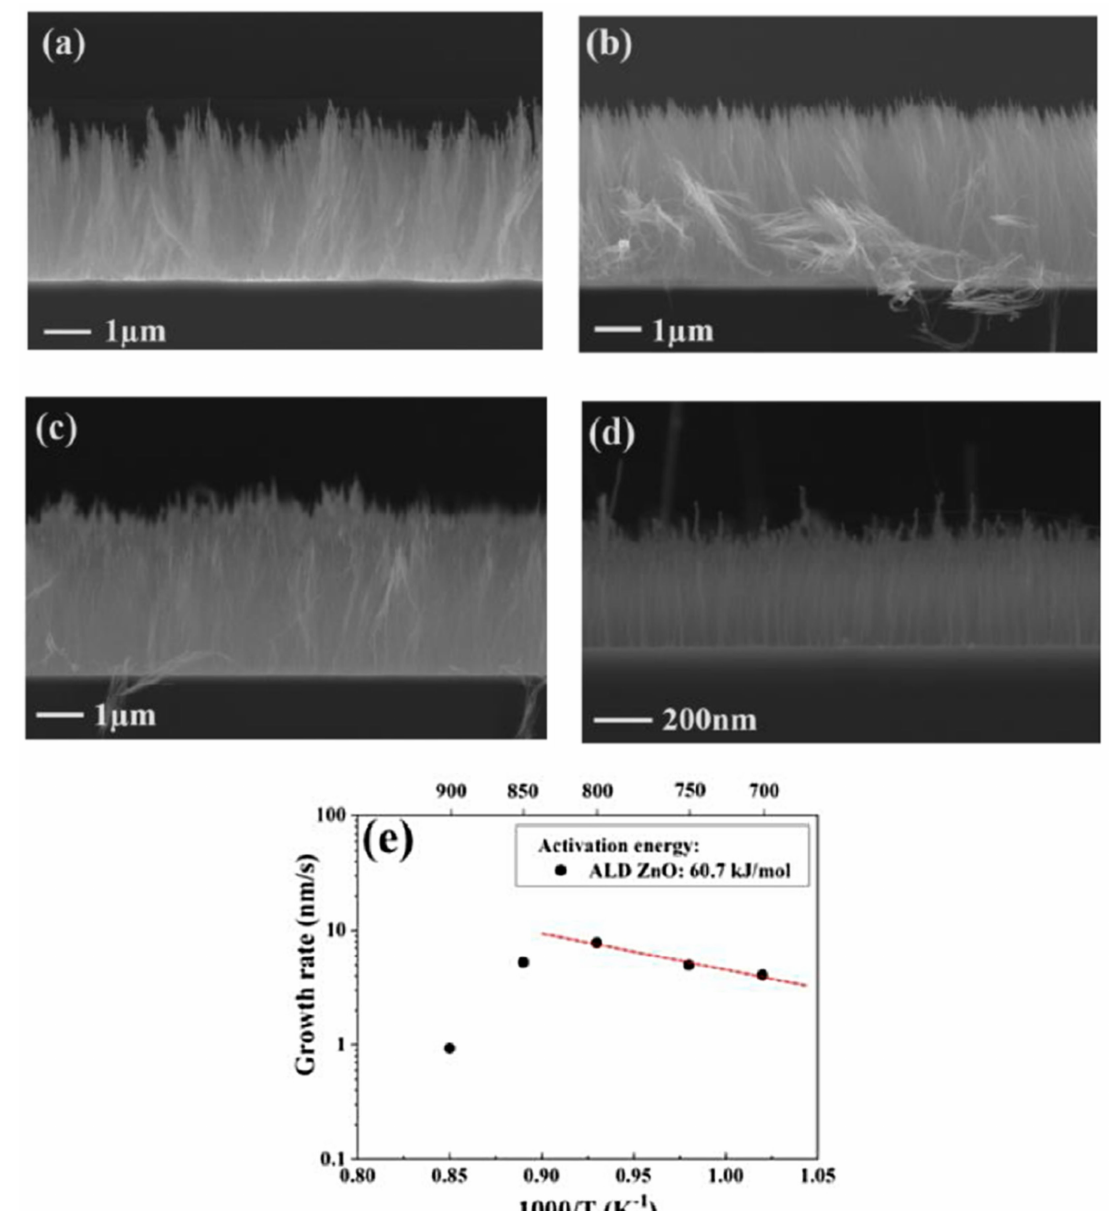
Figure 17. Cross-sectional SEM micrographs of CNT growth on the ZnO film at: ( a ) 700 ◦ C; ( b ) 750 ◦ C; ( c ) 850 ◦ C; ( d ) 900 ◦ C; and ( e ) presents the linear interpolation of the slopes from the growth rate of VACNT differences as a function of the deposition temperature, with an insert of the calculated activation energy. Reprinted with permission from Yuan, Chemical Physics Letters; Ref. [94] copyright 2021,